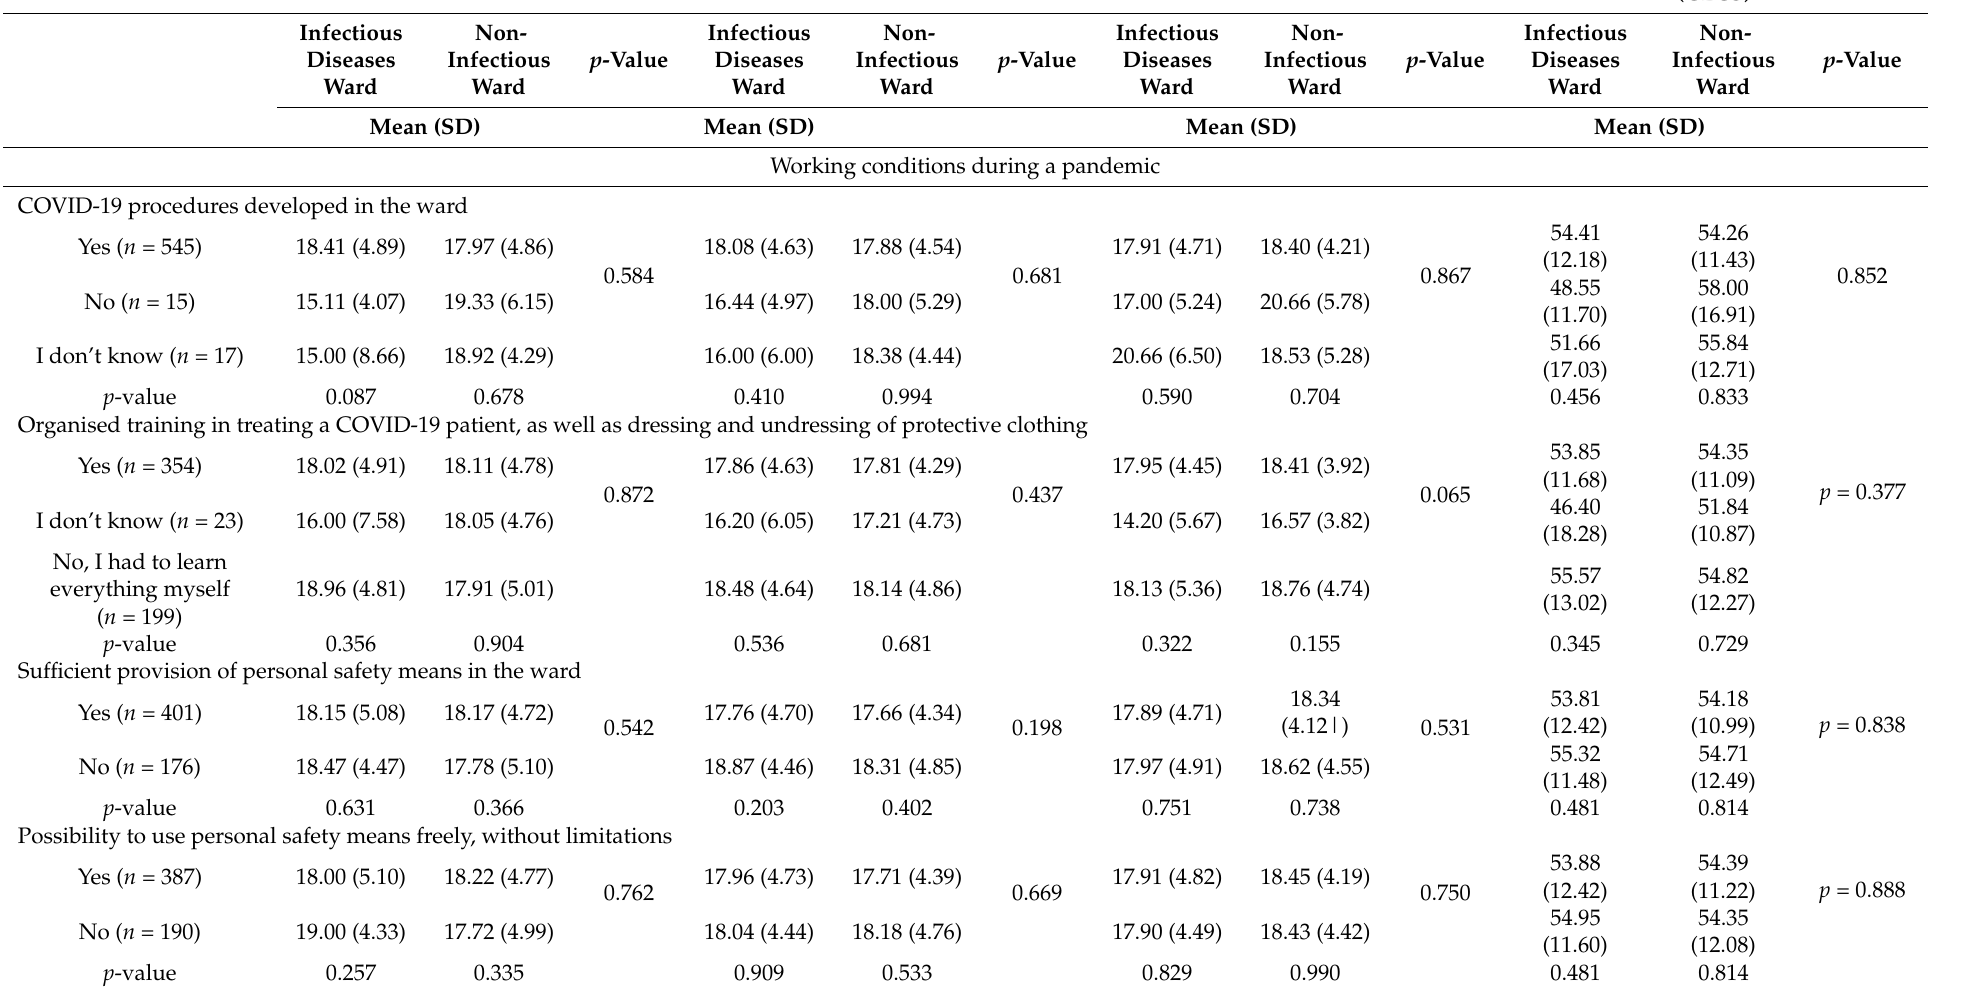
General Emotional Control Index (CECS)